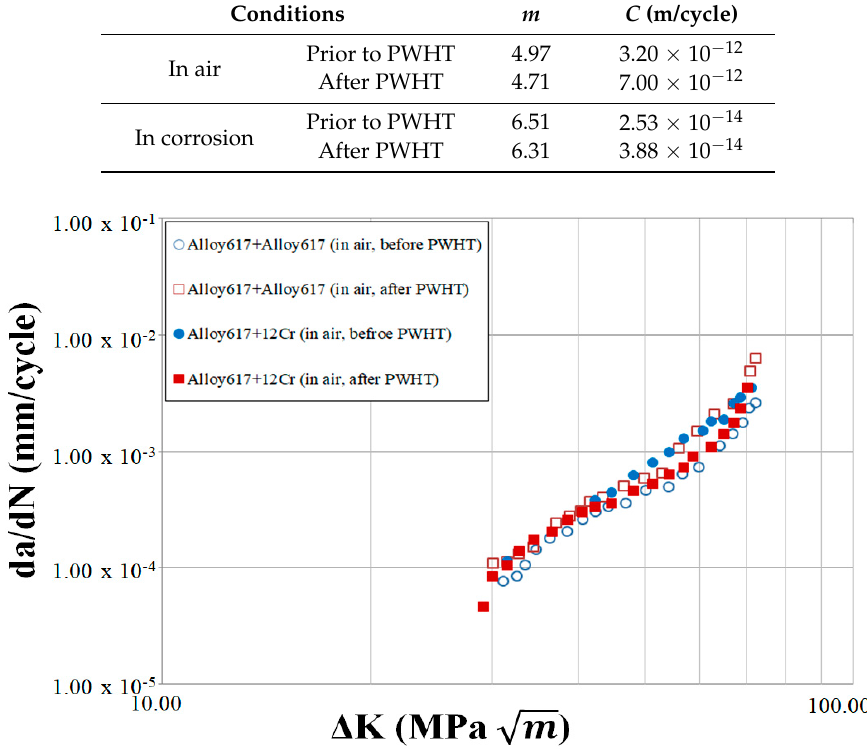
Figure 10. Relationship between d a /dN– ∆ K in air (reproduced from [12], with permission from World Scientific, 2018).